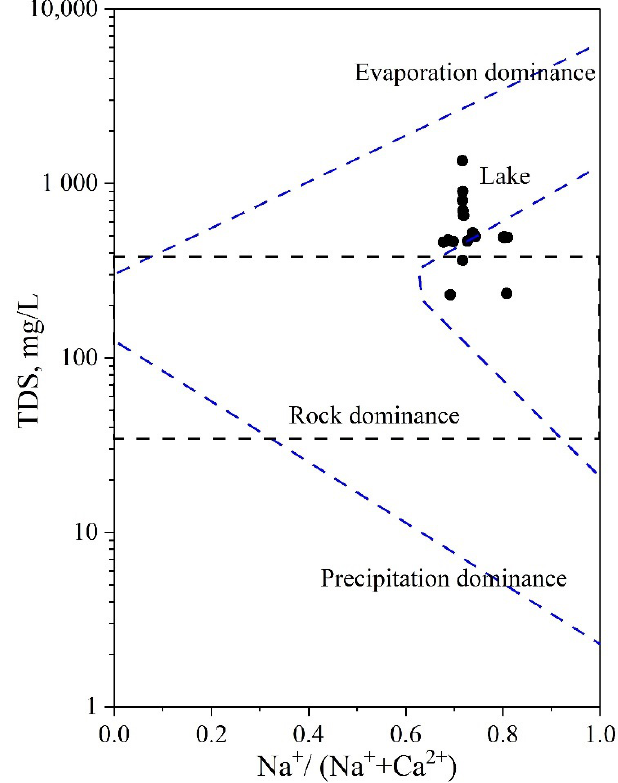
Figure 3. Gibbs plot of surface and bottom water samples from Lake Bulan. Note: closed circles—the ratio of cations [(Na + )/(Na + + Ca 2+ )] against TDS in water Lake Bulan.